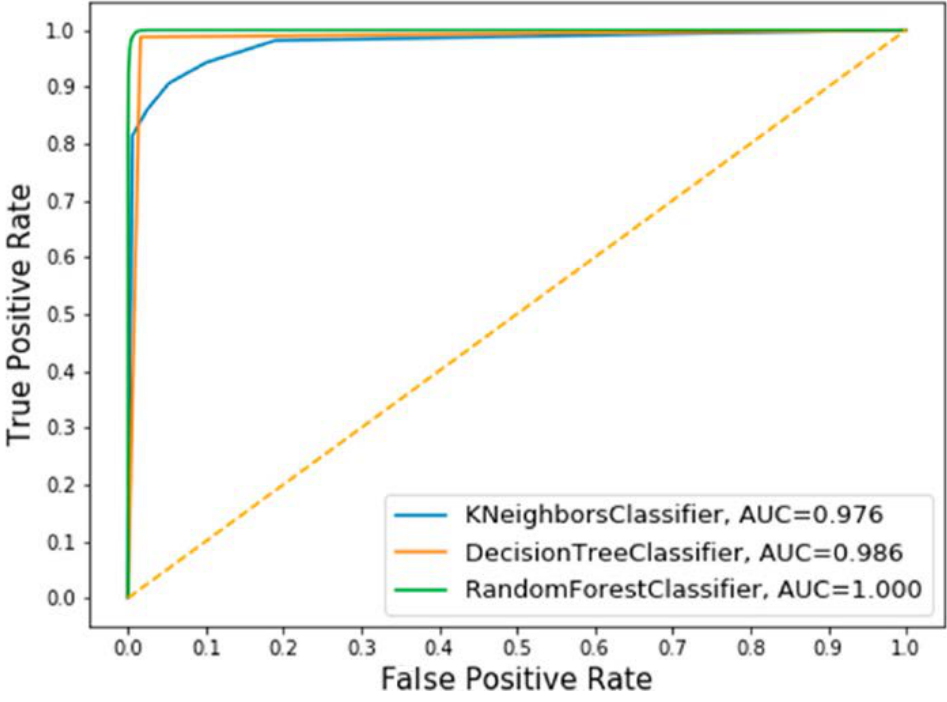
Figure 44. Combined ROC curve for proposed machine learning classifiers [117].